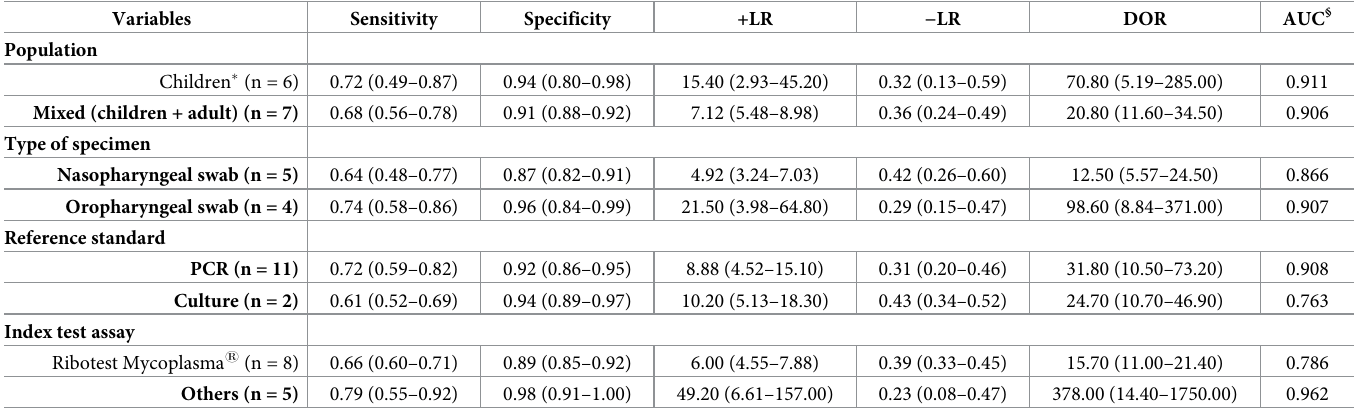
Table 3. Subgroup analyses: Summary estimates using a bivariate random effects